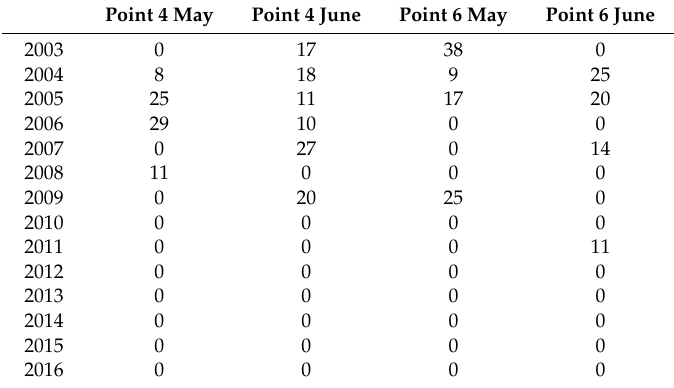
Table 3. Monthly frequency (%) of IOP index values > 1.6 by year from 2003 to 2016. Frequency of IOP index (%) is calculated as number of cases divided by number of month